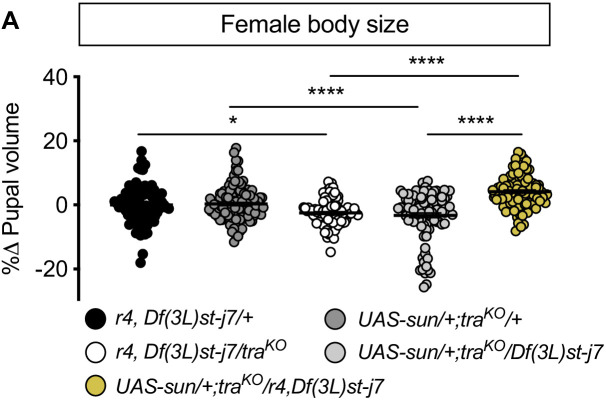
Fat body stunted (sun) overexpression is sufficient to rescue the reduced body size of transformer (tra) mutant females in a protein-rich (2Y) diet.(A) In females, pupal volume was significantly smaller in tra mutant r4-GAL4 control females compared to r4-GAL4 control females with one copy of tra (p=0.0194 [r4,Df(3L)st-j7/+ v r4,Df(3L)st-j7/traKO]; one-way ANOVA followed by Tukey HSD test). Pupal volume was significantly smaller in tra mutant UAS-sun control females compared to UAS-sun control females with one copy of tra (p<0.0001 [UAS-sun/+; traKO/+ v UAS-sun/+; traKO/Df(3L)st-j7]; one-way ANOVA followed by Tukey HSD test). Pupal volume was significantly larger in tra mutant females with fat body overexpression of sun compared to tra mutant controls (p<0.0001, for both comparisons; one-way ANOVA followed by Tukey HSD test). n = 94–117 pupae. For body size graphs, filled circles indicate pupal volume and error bars indicate SEM. * indicates p<0.05, **** indicates p<0.0001; error bars indicate SEM.